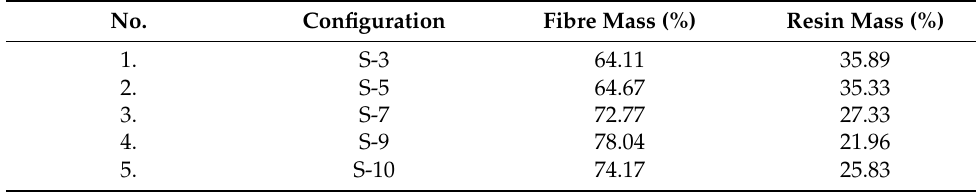
Table 2. Fibre and polymer fraction mass for each configuration.